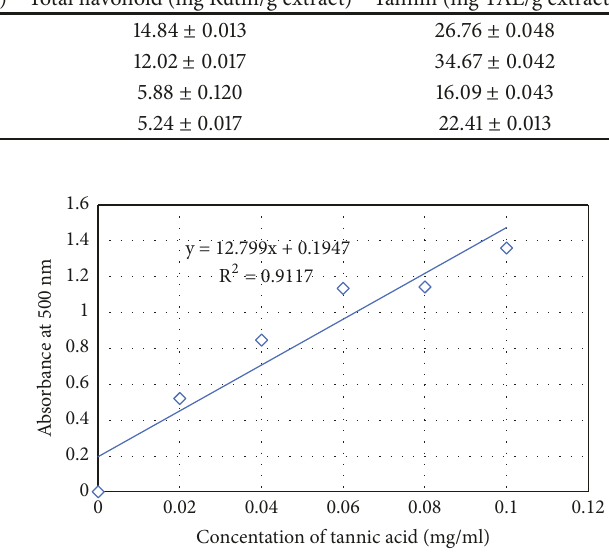
Figure 4: Calibration curve of tannic acid in determination of tannin present in C. edulis